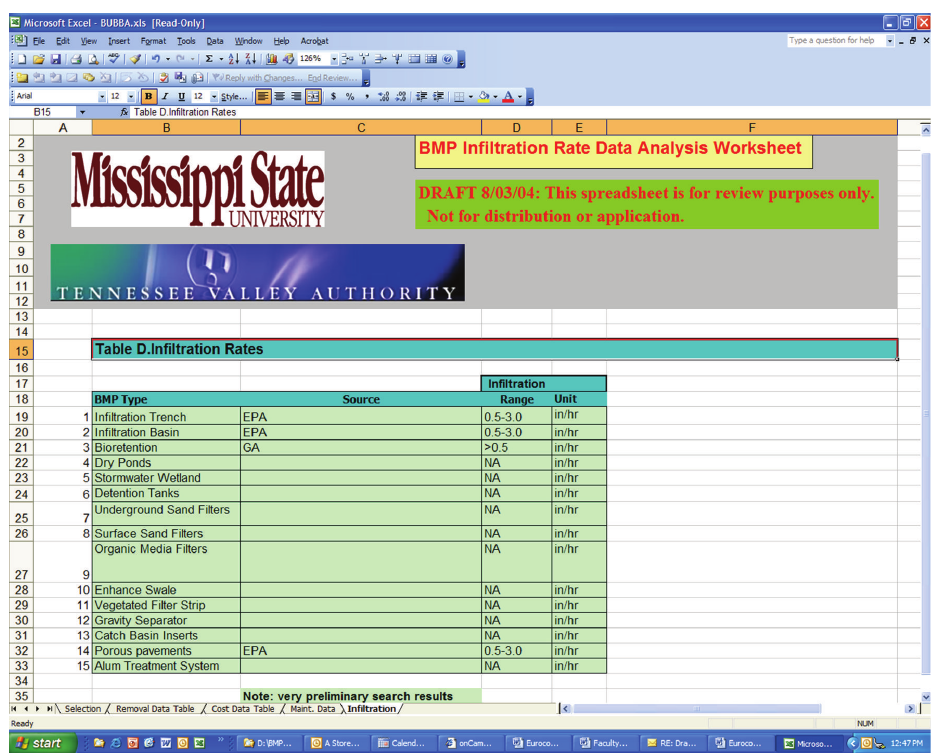
Figure 6: The Infiltration Data Table